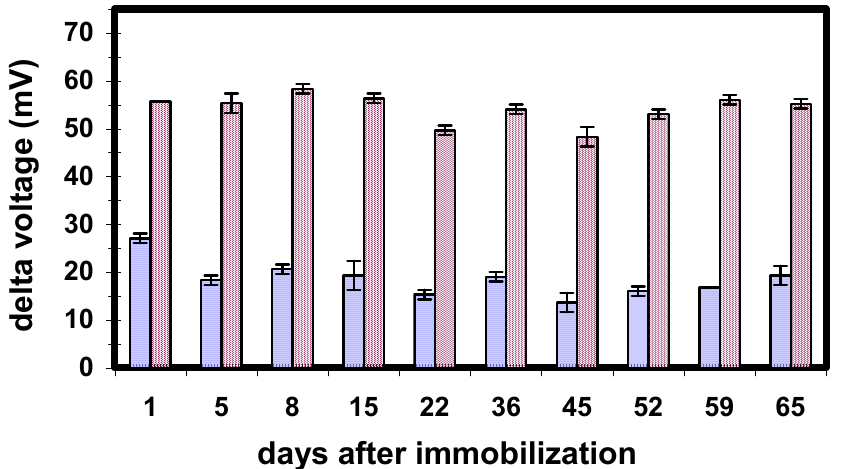
Figure 8. Long-term stability of the enzyme biosensor with Ta signals of 15 µM paraoxon (small bars) and 50 µm paraoxon (large bars) are plotted over